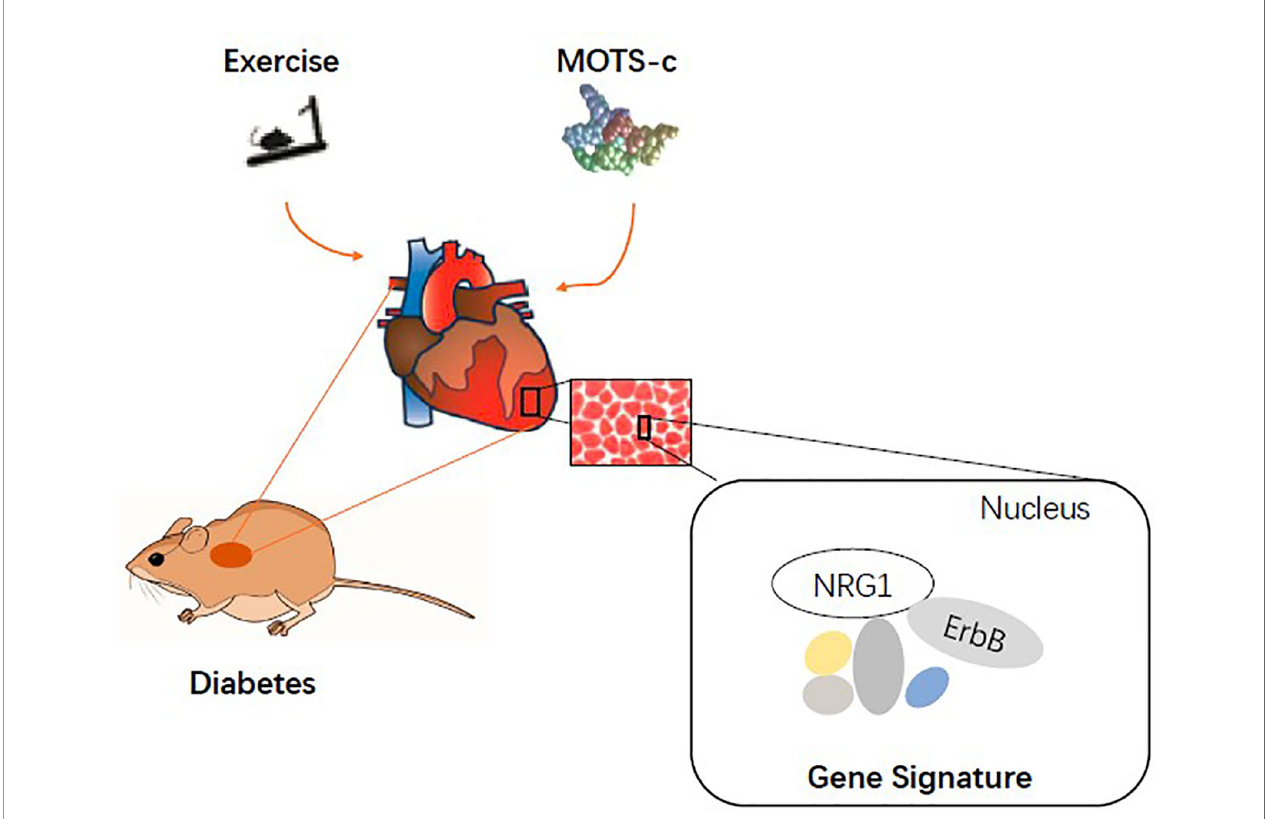
FIGURE 7 | Model depicting the overlapping mechanisms between exercise and MOTS-c supplements in restoring cardiac function in